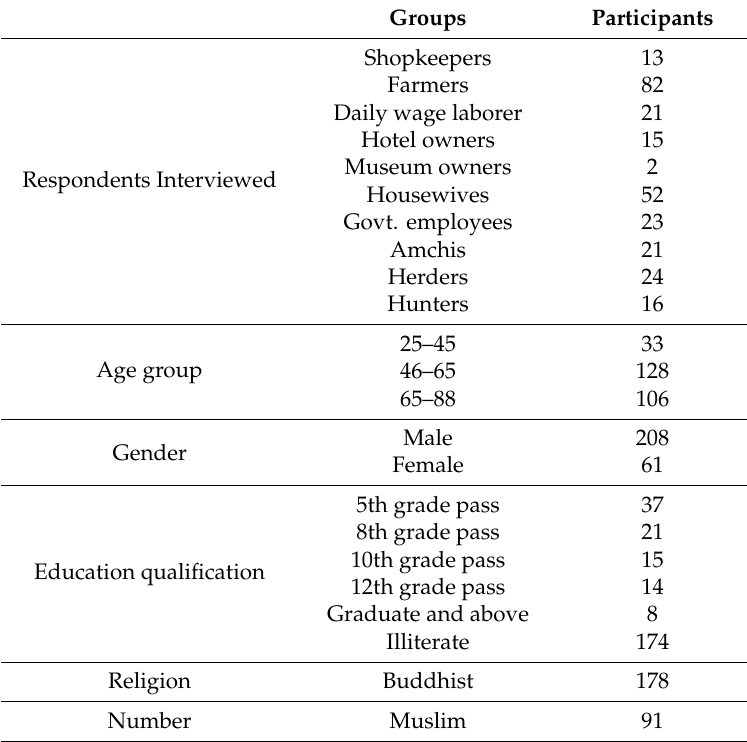
Table 1. Details of respondents interviewed in the present